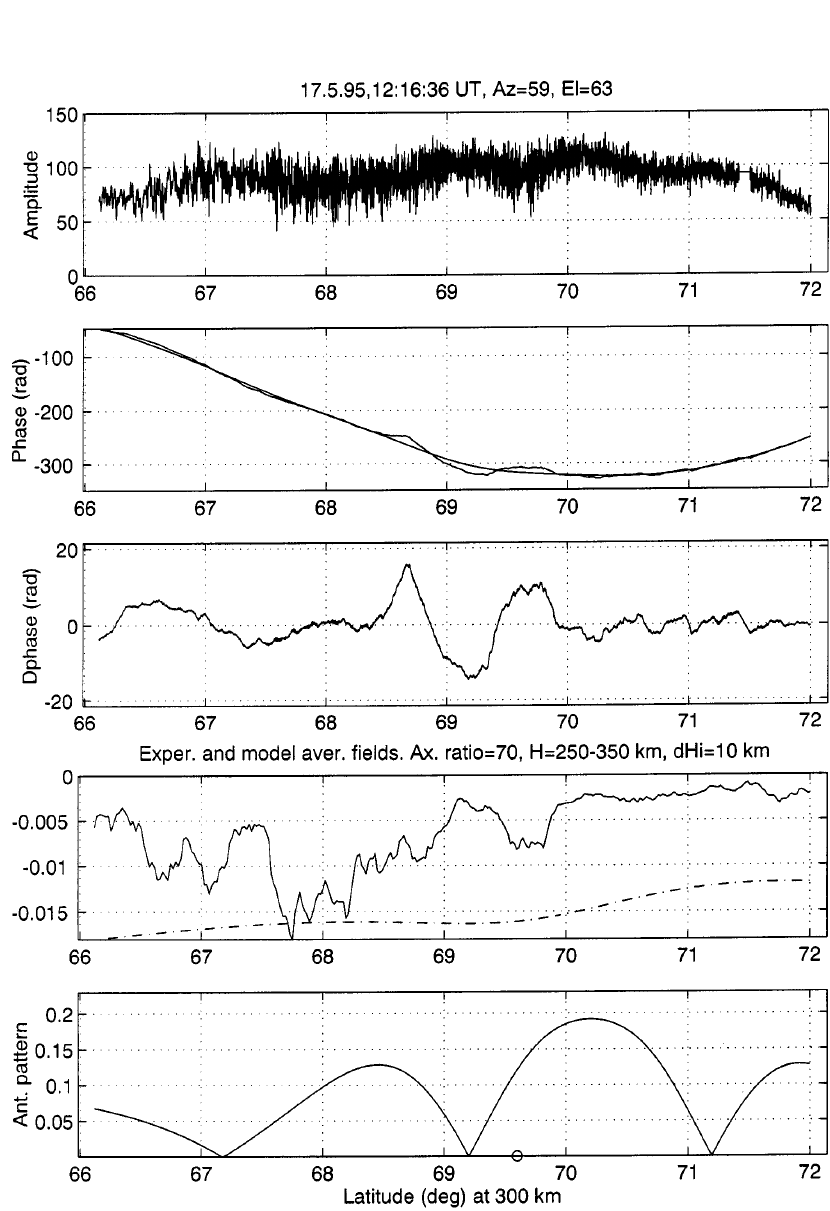
Fig. 3. Same as Fig. 2, but for the next satellite passage during the operation of the